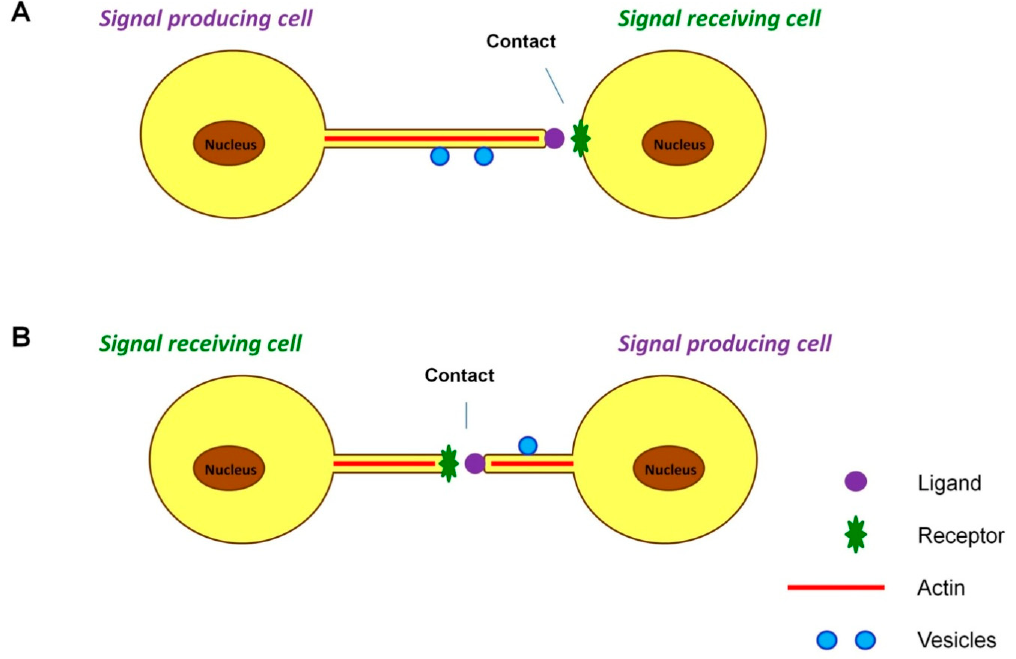
Figure 2. Cell signaling by cytonemes. Cytonemes are specialized closed-ended actin-based signaling filopodia. Cytoneme signaling in cells occurs due to the interaction of a ligand produced by the signaling cell localized on a growing thin membrane protrusion, which is a cytonema, with the receptor of the cell that receives the signal. ( A ) Cytonemes can grow from signal-producing cells towards receiving ones and vice versa. ( B ) The cytonemes may also be initiated by both types of cells and grow towards each other. The formation of cytonemes ends with the establishment of contact between cells. The transport of vesicles takes place on the surfaces of cytonemes, in contrast to tunneling nanotubes and intercellular bridges, where the transport of vesicles and larger cellular components can be carried out inside these membrane